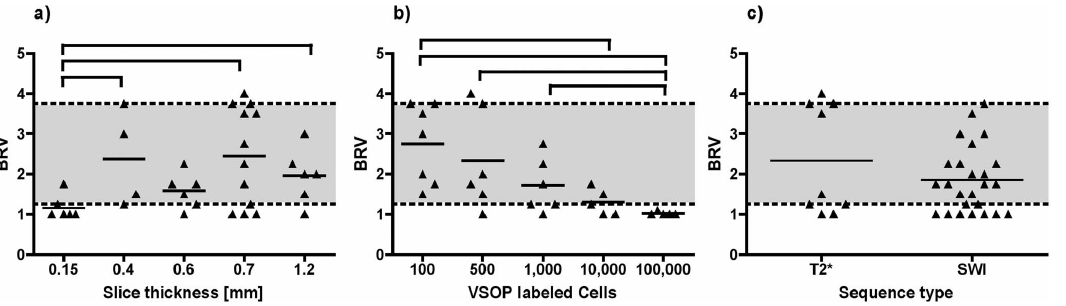
Figure 6. Further analysis of the rater based evaluation. Images were rated and the Blinded Rater Value (BRV) was established as described in the methods section. Significant differences (p , 0.05) are indicated by brackets. The grey area between a BRV of 1.25 and 3.75 indicates BRVs regarded as ‘‘probably not detectable’’ or ‘‘probably detectable’’. (A) Differences in BRV in relation to slice thickness of the sequence are demonstrated, regardless of other sequence parameters, sequence type or amount of labeled cells. A lower slice thickness resulted in significantly lower BRVs indicating improved detectability of cells. (B) BRVs in relation to the number of labeled cells per layer are shown. Layers with higher cell counts result in significantly lower BRVs. (C) Relationship between BRV and the imaging sequence type (SWI or T2* weighted) is shown. Differences were not statistically significant. doi:10.1371/journal.pone.0062644.g006 PLOS ONE |